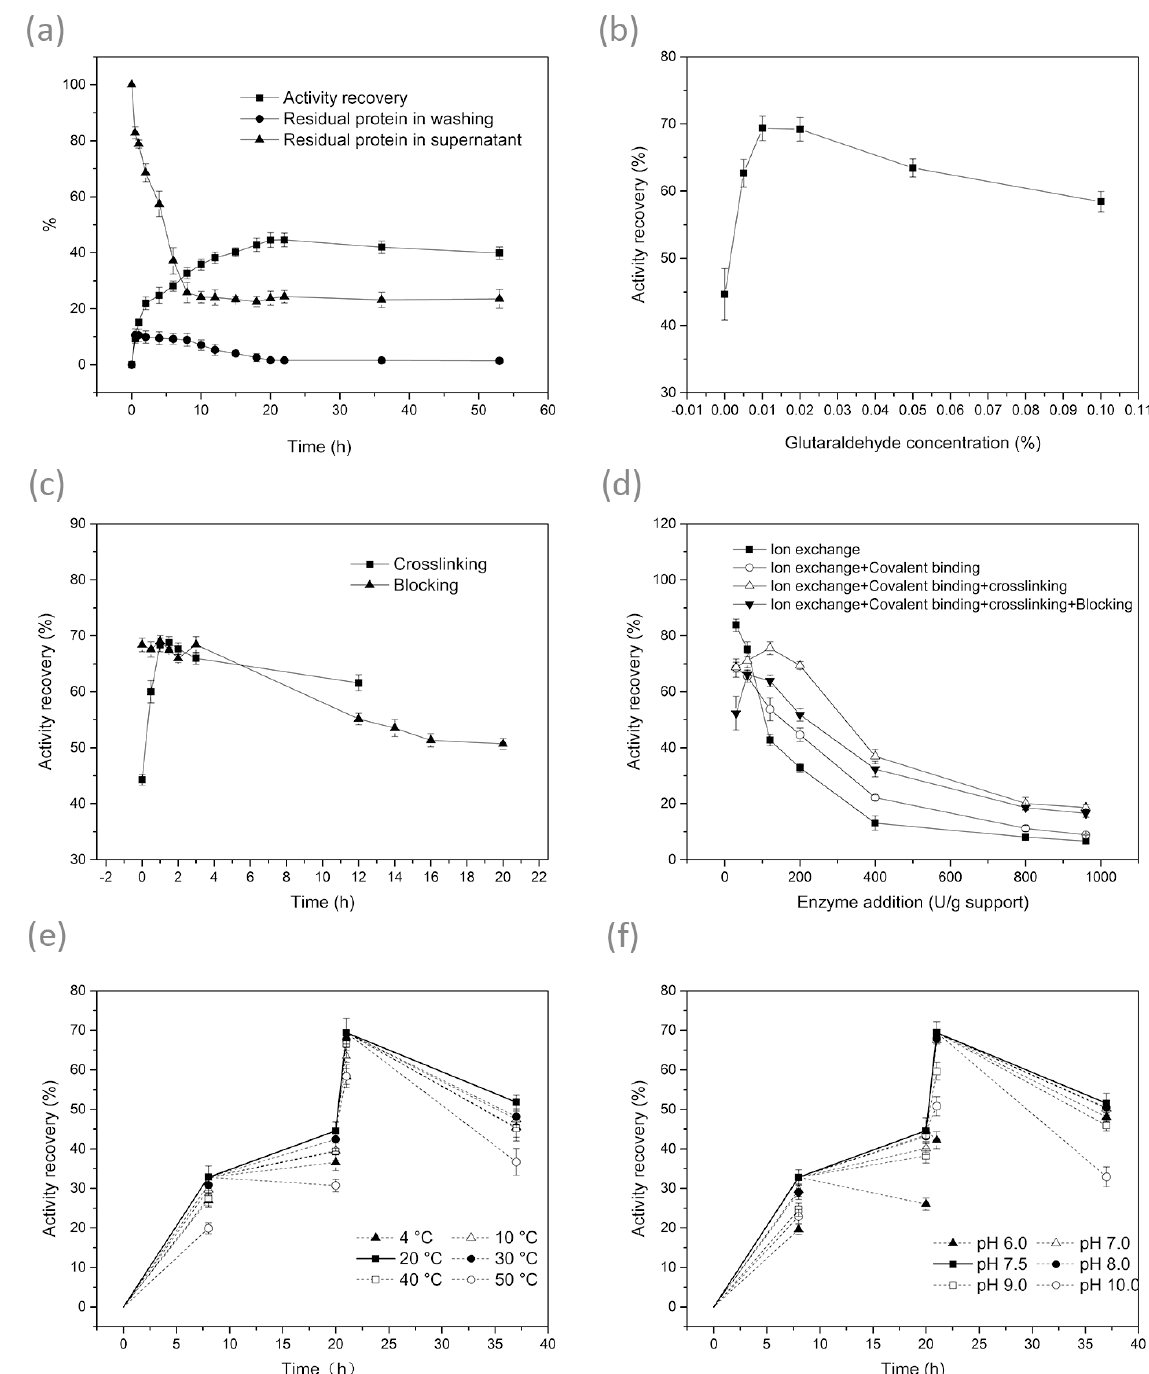
Figure 2. Effect of conditions on immobilisation. ( a ) Time of ion exchange and covalent binding; ( b ) concentration of glutaraldehyde; ( c ) time of crosslinking and blocking; ( d ) enzyme dosage; ( e ) temperature; 0–8 h: Ion exchange; 8–20 h: Covalent binding; 20–21 h: Crosslinking; 21–37 h: Blocking; ( f ) pH; 0–8 h: Ion exchange; 8–20 h: Covalent binding; 20–21 h: Crosslinking; 21–37 h: Blocking.